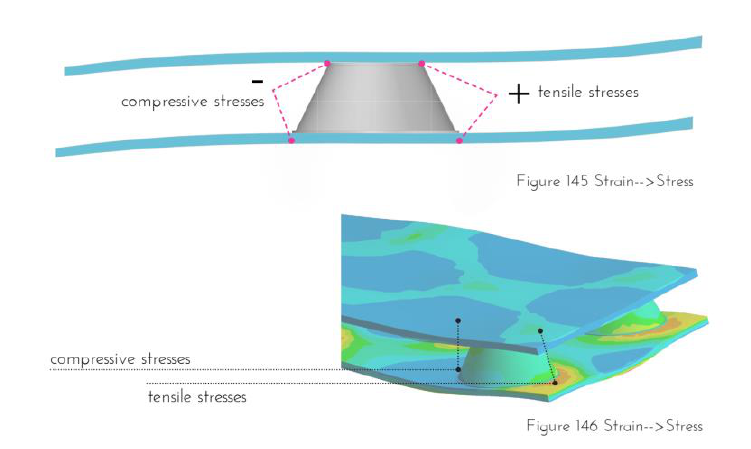
Fig. 3 FEM modelling.